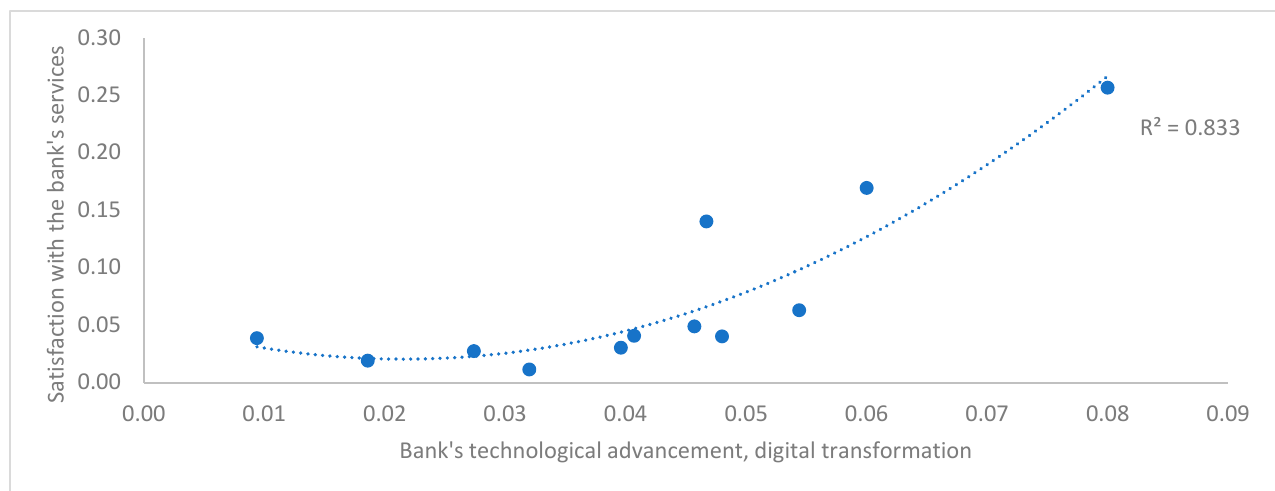
Figure 4. Customer satisfaction of banking services in relation to bank technological advancement, 2Q 2021. Source: own computation based on data from ZBP 2021.